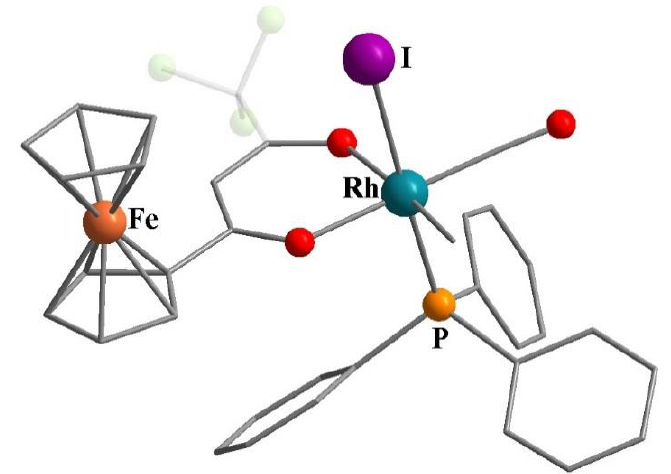
Figure 30. Molecular structure of 60 [101]. Hydrogen atoms have been omitted, CF 3 group is transparent for clarity. The cif has been retrieved from CCDC. CCDC number is 646438.